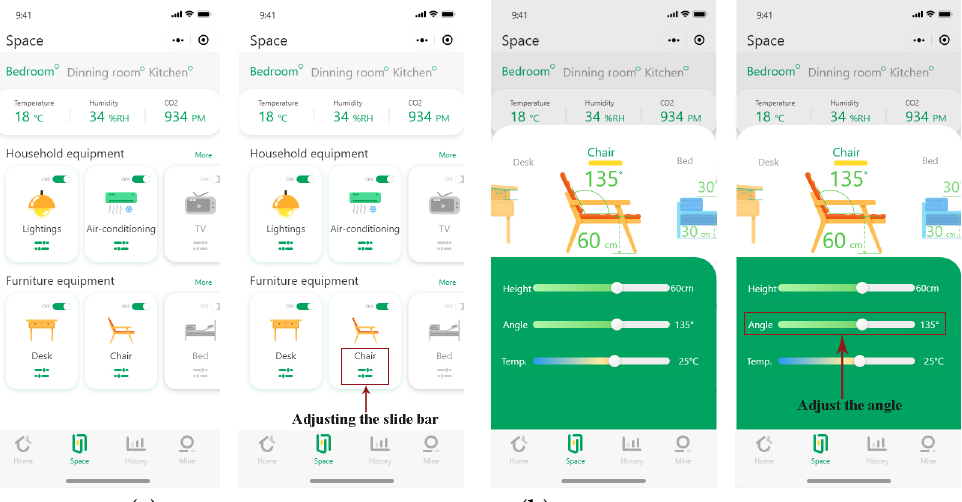
Figure 3. Interface for